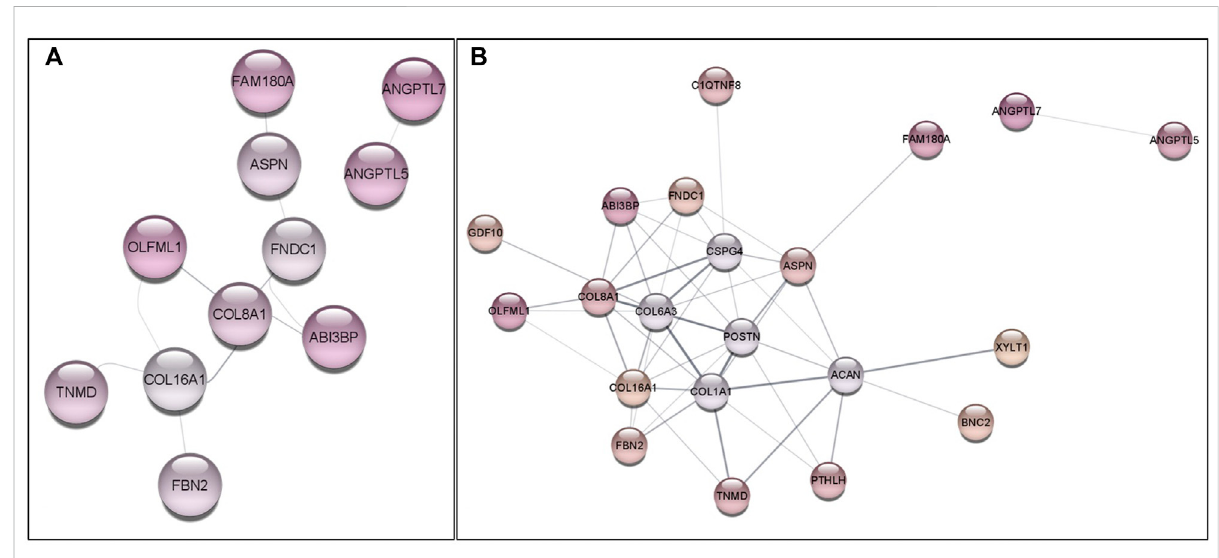
FIGURE 3 Gene network constructed with DE genes (A) and with DE genes plus up to 5 protein interactors (B) with the Gallus gallus information. Colored circles represent genes and connecting lines represent interactions among genes, according to Cytoscape Stringdb App. Colors indicate the downregulation expression levels, where darker colors have lower logFC levels in FHS-affected group. Gray circles (B) are protein interactors added to improve the gene network information.